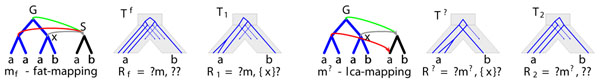
Reconciliations. Reconciliations for the gene tree G and the species tree S. Only two mappings from G to S exist: the lca-mapping m*, and the mapping mf. There are 4 possible reconciliations: R*, R1, R2 and Rf. The diagram presents the embeddings of G, S, in which T*, T1, T2 and Tf corresponds to R*, R1, R2 and Rf, respectively. Only node x is the lca-speciation.